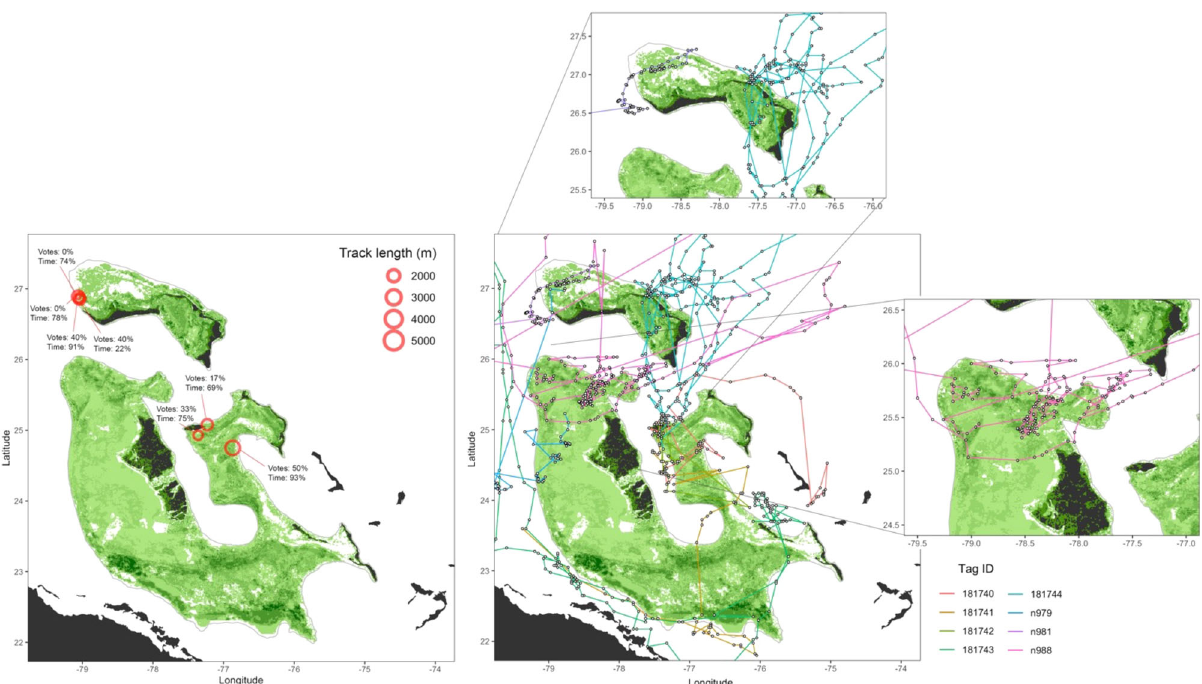
Fig. 3 | Tiger shark survey coverage on The Bahama Banks. Tracking locations from camera tags (left); Votes indicates the percentage of votes from seagrass estimates (see Supplementary Tables 1 and 2 for details) from the release location for the camera tag, and Time indicates the percentage of time the camera-tagged